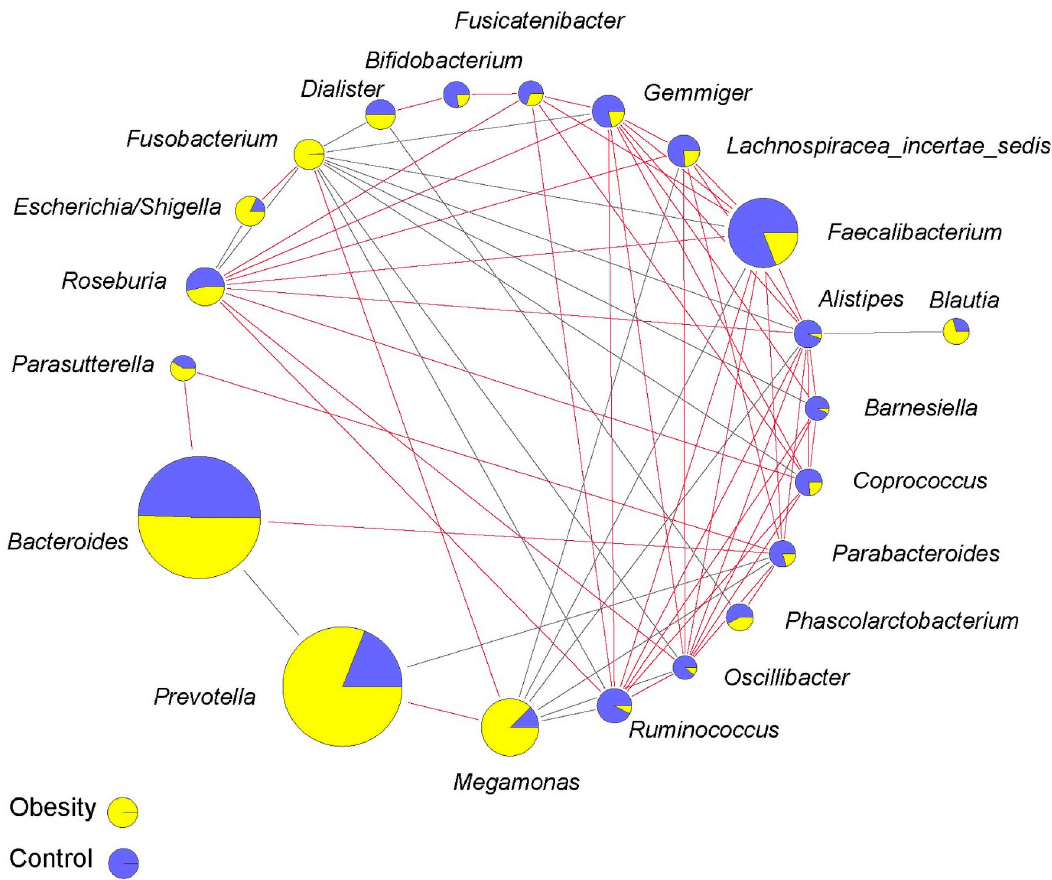
Fig 7. SparCC correlation networks observed between genera. The pie charts show relative genera proportions in the Obesity (yellow) and Control groups (blue), and the circle size represents the reads number. Line color: red (positive relationship) and grey (negative